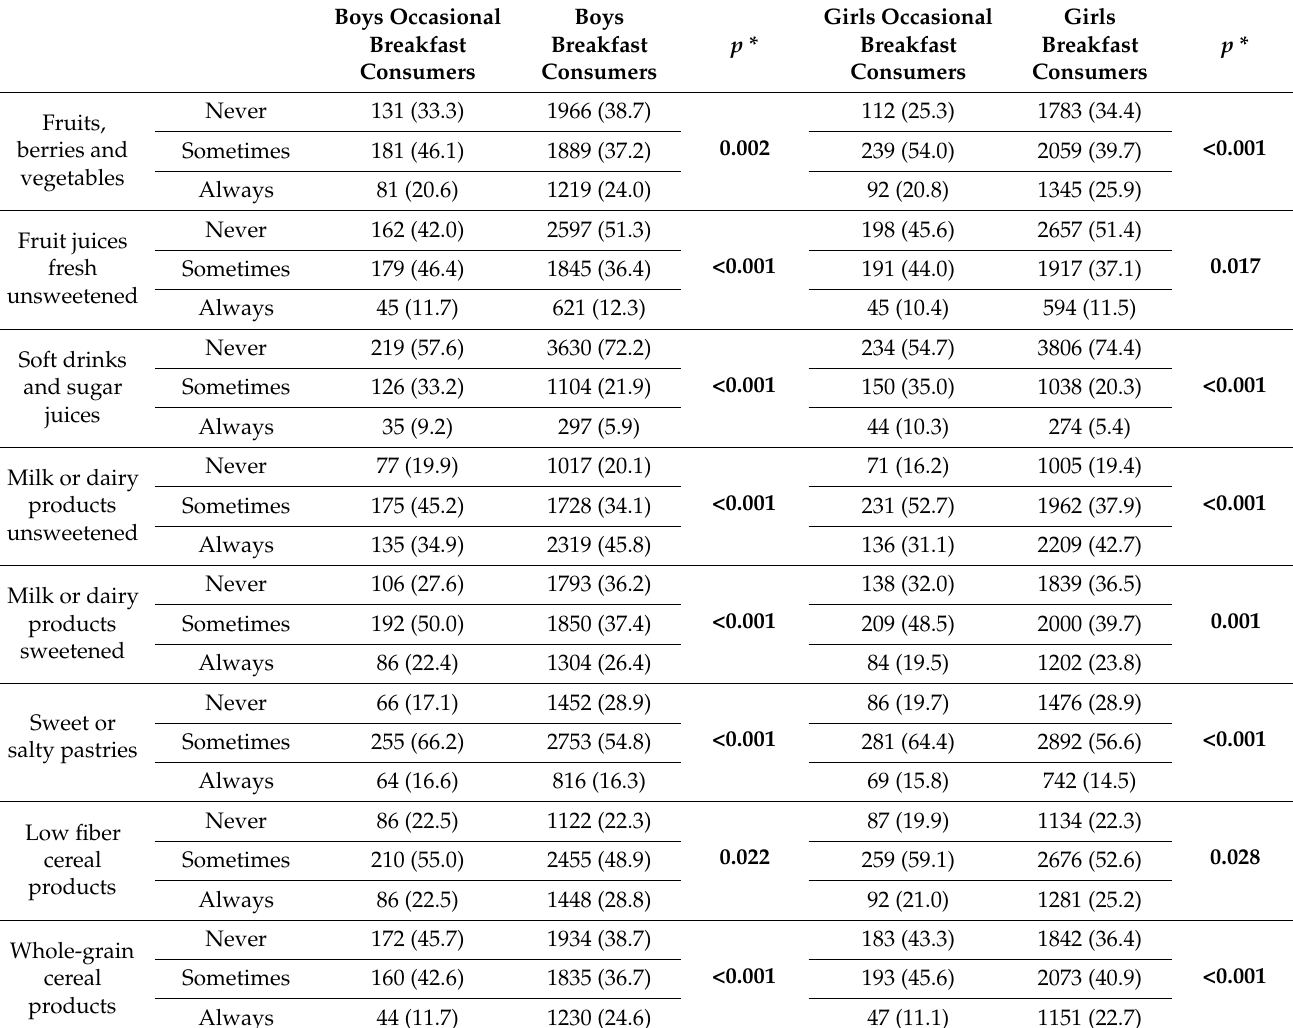
Table 2. Description of food and beverages consumed at breakfast in children who occasionally or usually consumed